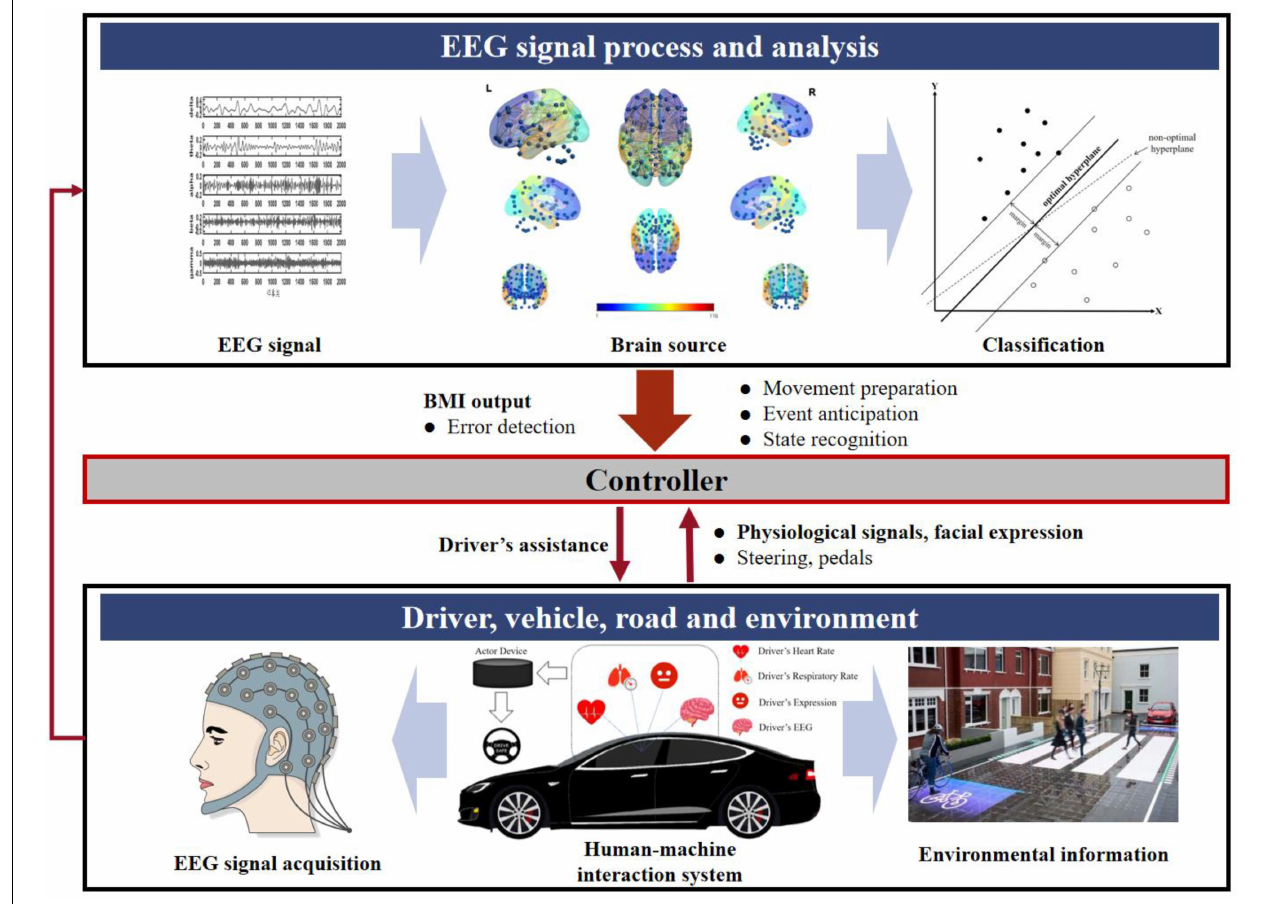
FIGURE 1 | Driving assistance system considering driving